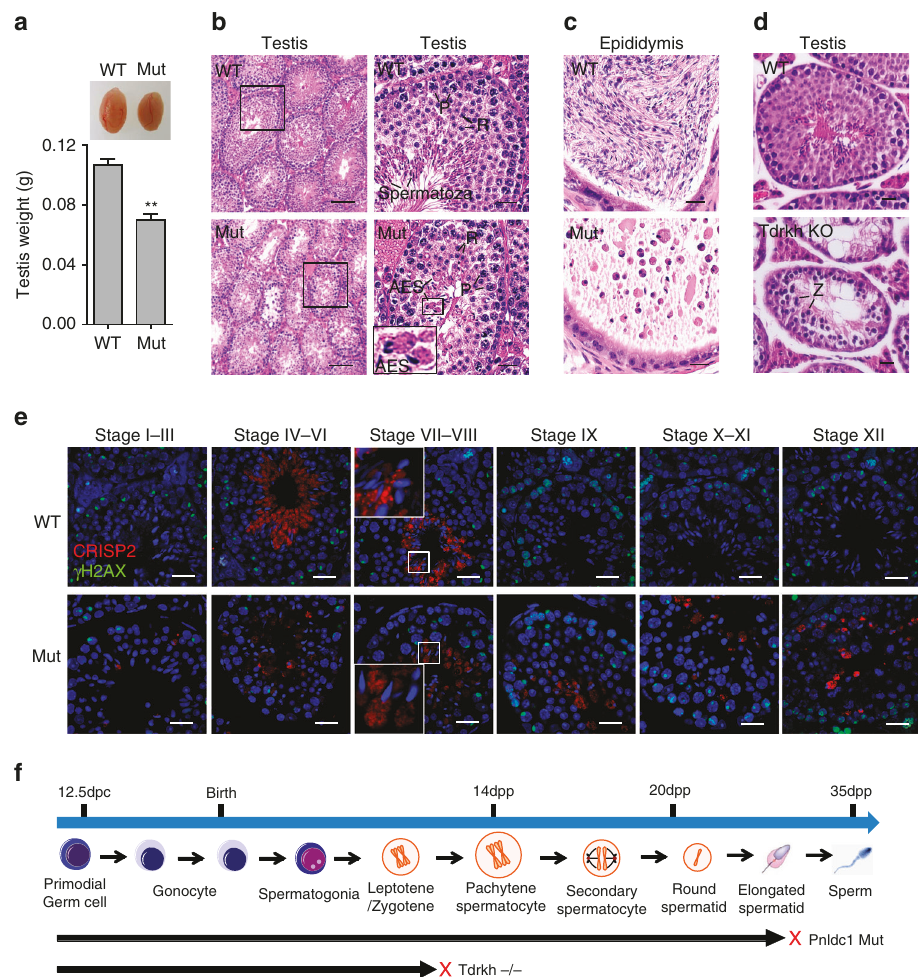
Fig. 1 Pnldc1 is essential for spermatogenesis. a Testicular atrophy in Pnldc1 Mut mice. Testis sizes and weights of adult wild-type ( WT ) and Pnldc1 Mut mice are shown. n = 5; signi fi cance determined by unpaired Student ’ s t -test; ** p < 0.01. Error bars represent s.e.m. b Spermiogenic arrest in adult Pnldc1 Mut mice. Hematoxylin and eosin-stained testis sections from adult WT and Pnldc1 Mut (Mut-5) mice are shown. AES abnormal elongated spermatids, P pachytene spermatocytes, R round spermatids. Scale bars , 100 μ m ( left ) and 20 μ m ( right ). c Hematoxylin and eosin-stained epididymis sections from adult WT and Pnldc1 Mut (Mut-5) mice are shown. Scale bar , 20 μ m. d Meiotic arrest in adult Tdrkh KO mice. Hematoxylin and eosin-stained testis sections from adult WT and Tdrkh KO mice are shown. Z zygotene spermatocytes. Scale bar , 20 μ m. e Co-immunostaining of CRISP2 ( red ) and γ H2AX ( green ) in adult WT and Pnldc1 Mut (Mut-1) testes. DNA ( blue ) is stained by DAPI. Spermatogenic stages are noted. Scale bar , 20 μ m. f The timeline of mouse spermatogenesis with red crosses representing the arrested spermatogenic stages in Pnldc1 Mut and Tdrkh KO